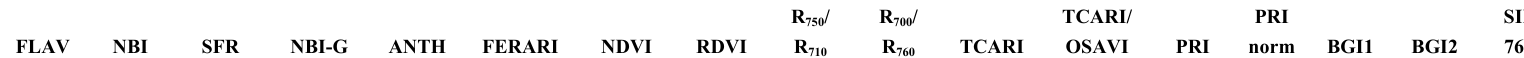
Table 5. Pearson correlation coefficients obtained for linear correlations between optical indices and between optical indices and crop parameters at maize flowering.